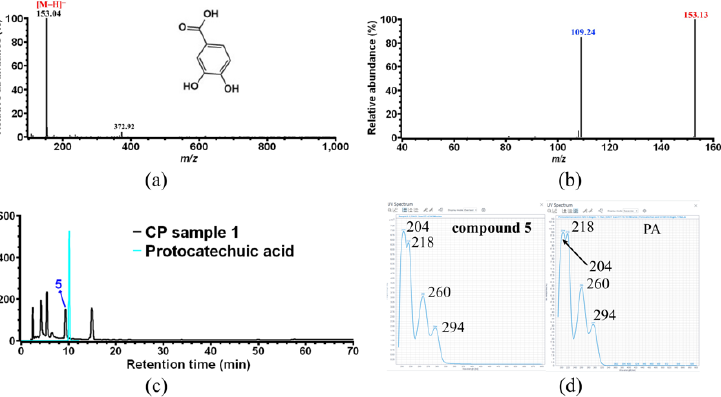
Figure 6. Identification of CP compound 5. ( a ) MS analysis of compound 5; ( b ) MS/MS analysis of the ion with m/z 153.04 obtained in ( a ); ( c ) HPLC overlay chromatogram of CP sample 1 and commercial PA standard; ( d ) UV-vis spectrum analysis of compound 5 and PA standard.